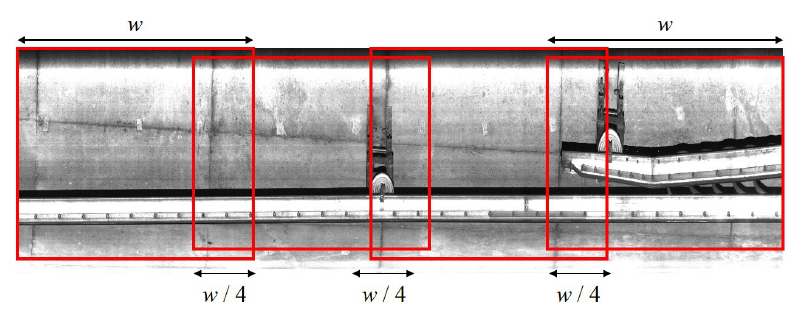
Figure 7. Split strategy of the proposed detection